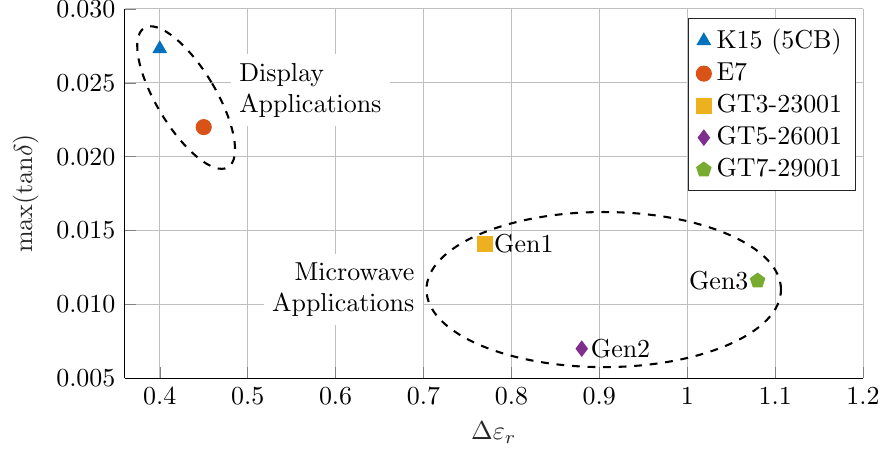
Figure 3. Dielectric anisotropy versus maximum loss tangent of different LC mixtures at 19GHz. Values provided by Merck KGaA and [7]. Gen1 to Gen3 indicate the different generations of the